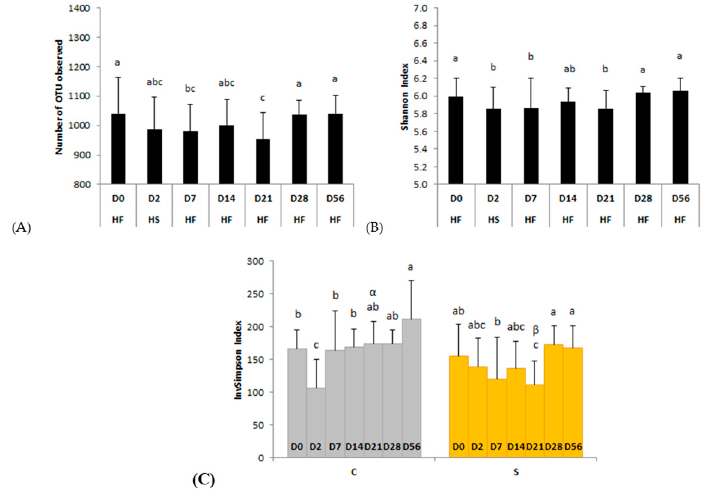
Figure 2. Modifications of the bacterial diversity and richness assessed by ( A ) the number of observed operational taxonomic units (OTUs), ( B ) Shannon, and ( C ) InvSimpson indexes during two consecutive dietary changes from high-fiber (HF) to high-starch (HS) diet and vice versa. On plots ( A , B ), means with different superscripts differ at p < 0.05 for each day. On plot ( C ), different Latin superscripts (a, b, c) represent significant variations between days for each supplementation whereas different Greek superscripts ( α , β ) describe significant variations between supplementations for each day. Error bars are based on standard deviations for each day (D).